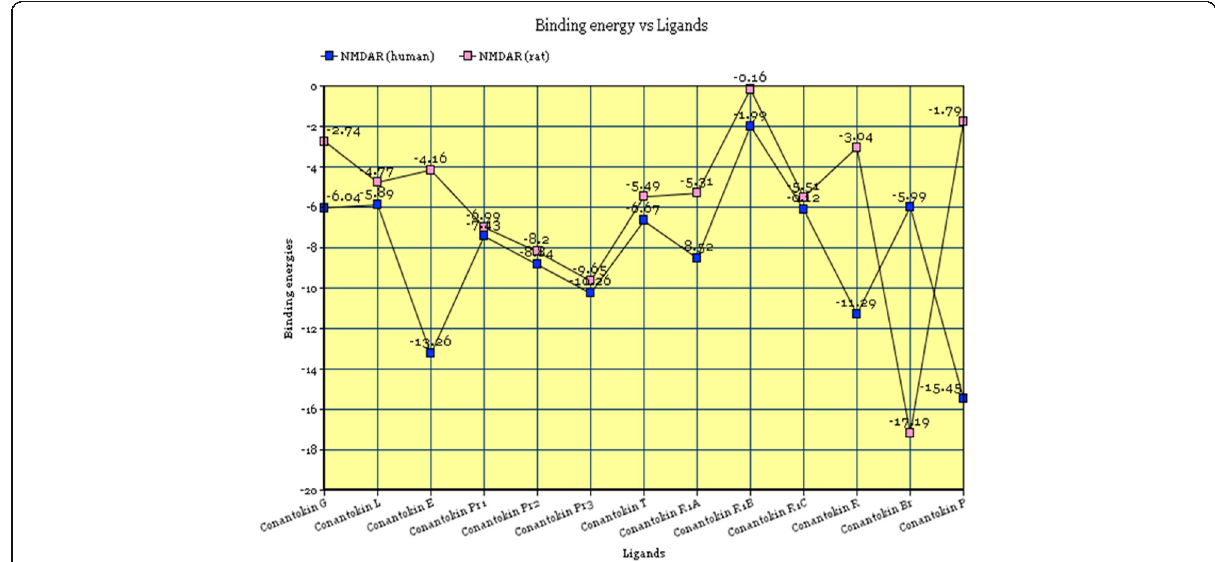
Fig. 8 Graphical plot of binding energies versus toxin ligands